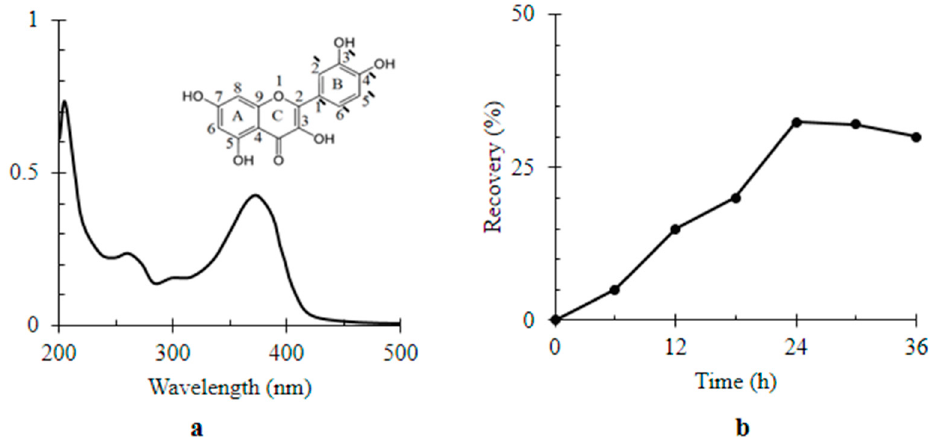
Figure 2. Colorimetric assay of quercetin (Q) ( a ) UV-visible spectrum of Q [1 × 10 − 6 M]. Inset the chemical structure of Q; ( b ) the rate of Q relative recovery by titanium dioxide-decorated multi-walled carbon nanotubes (MWCNTs/TiO 2 ) over time (36 h).